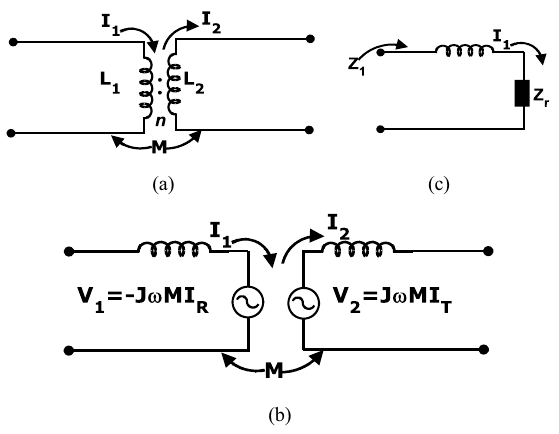
Figure 3: ICPT system phasor model: ( a ) inductive coupling circuit, ( b ) equivalent circuit, and ( c ) re fl ected impedance referred to the primary